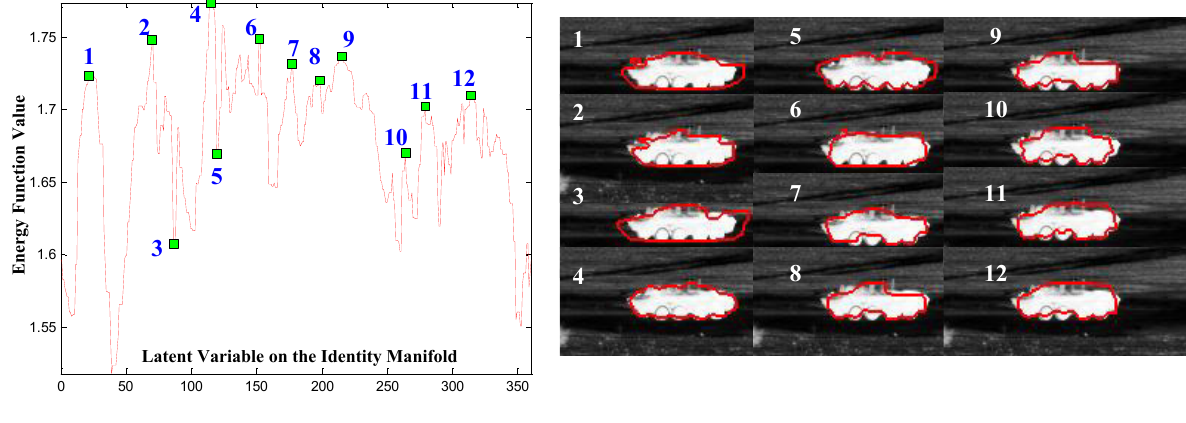
Figure 6. Effectiveness of the energy function. (Left) Plot of the energy function with respect to the identity latent variable; (right) a group of CVIM-generated shapes corresponding to the latent variables labeled in the plot on the left are superimposed onto the original IR data